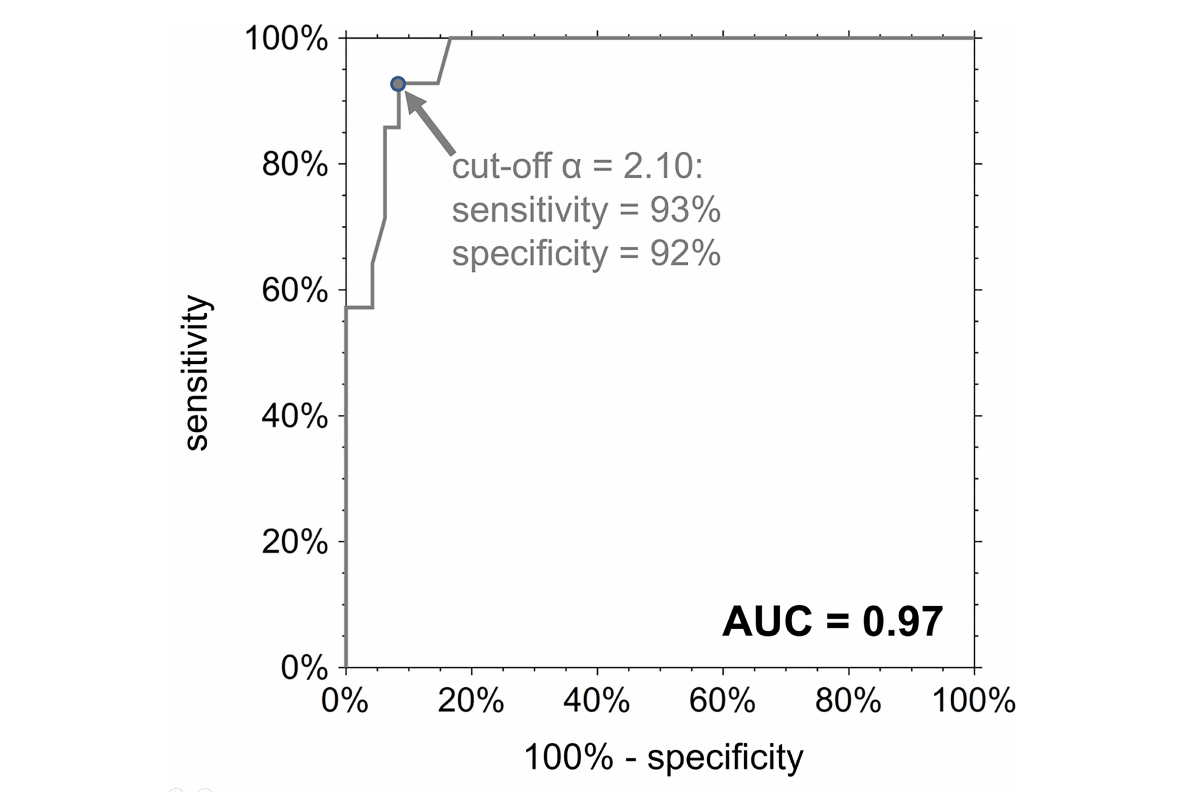
FIGURE4 ROC curve for the diagnosis of PAWP > 15 mmHg employing the LA acceleration factor α . AUC, area under the ROC